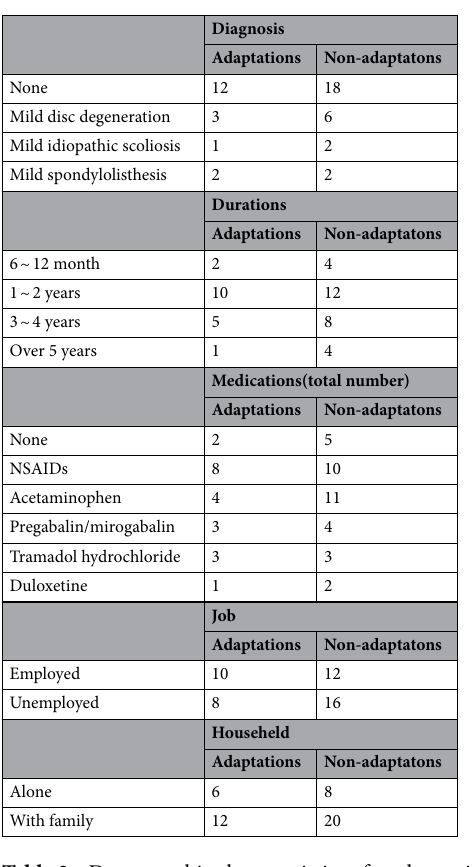
Table 3. Demographic characteristics of study participants.